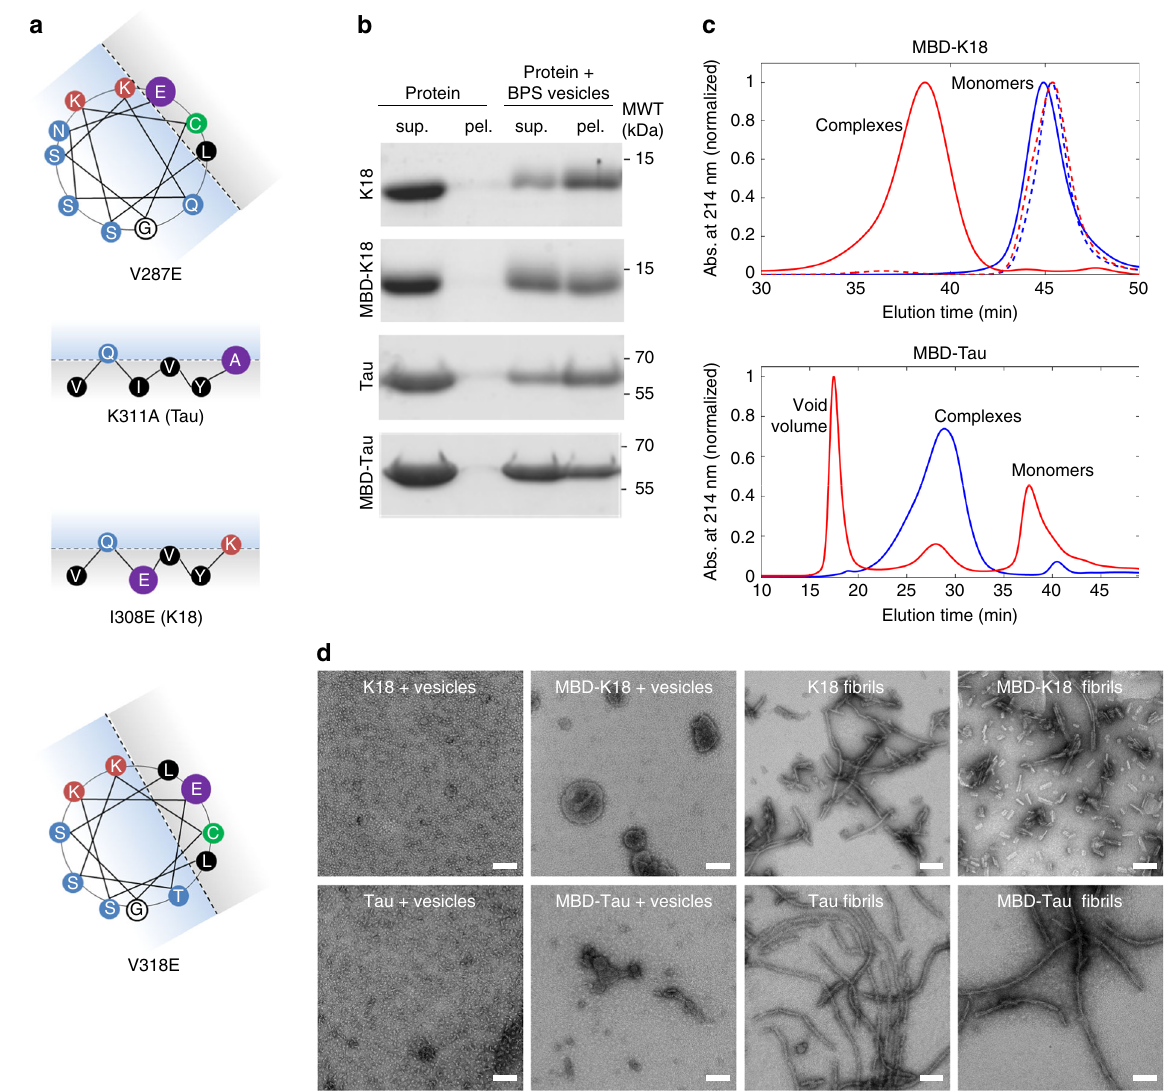
Fig. 7 Design and characterization of the membrane binding-de fi cient K18 and Tau mutants. a Helical wheel and β -strands depictions to illustrate the rational for the design of the K18 and Tau mutants. Mutations are in purple, hydrophilic residues in blue, hydrophobic residues in black, positively charged residues in red, cysteine in green, and glycine in white. The hydrophobic and hydrophilic faces of the helices are depicted in light gray and blue, respectively, and the putative position of the negatively charged phospholipid head groups are indicated by dashed lines. Mutation of a hydrophobic Val residue in the hydrophobic part of an amphipathic motif to a negatively charged Glu should interfere with the capacity of the segment to embed itself into the hydrophobic core of a membrane. In the case of Tau, the modi fi cation of positively charged Lys-311 to an uncharged Ala should affect its capacity to interact with negatively charged membranes through electrostatic interactions. b Co-sedimentation assay of BPS vesicles with WT and MBD-K18 (top) and Tau (bottom). When incubated alone (left), all proteins remain in the supernatant (sup.), but in the presence of BPS vesicles (right), the proteins partially co-sediment with the vesicles to the pellet (pel.), indicative of membrane binding. Compared with the WT proteins, more MBD-K18 and MBD-Tau proteins remain in the supernatant, indicating that they partially lost the ability to bind membranes. c Top: size-exclusion chromatograms of WT K18 (solid lines) and MBD-K18 (dashed lines) alone (blue lines) or with BPS vesicles (red lines) show that only WT K18 forms protein/phospholipid complexes. Bottom: size-exclusion chromatograms of WT Tau (blue line) and MBD-Tau (red line) show that WT Tau is ef fi cient in forming protein/phospholipid complexes (blue, large peak) while the capacity of MBD-Tau to form such complexes is compromised (red, small peak). d EM analysis of WT and MBD-K18 (top) and Tau (bottom) shows that the mutants cannot form protein/phospholipid complexes in the presence of BPS vesicles (second-to-left panels) but retain their ability to form fi brils (right-most panels). The scale bars are 100 biological membranes and to compare their internalization into Val-318 are signi fi cantly attenuated in the HSQC spectrum primary neurons with that of monomeric and fi brillar forms of (Fig. 5f, h), supporting these assignments. Two glycine signals suggest that the KCGS motifs (residues 290 – 293 and 321 – 324) with complexes formed by Tau or Oregon Green-labeled K18 might be part of the oligomer core as well. with BPS and assessed their uptake by immunocytochemistry (ICC) (Fig. 6, Supplementary Fig. 4). Initially, the fl uorescence signal strongly localized to the plasma membrane, but after 1 day